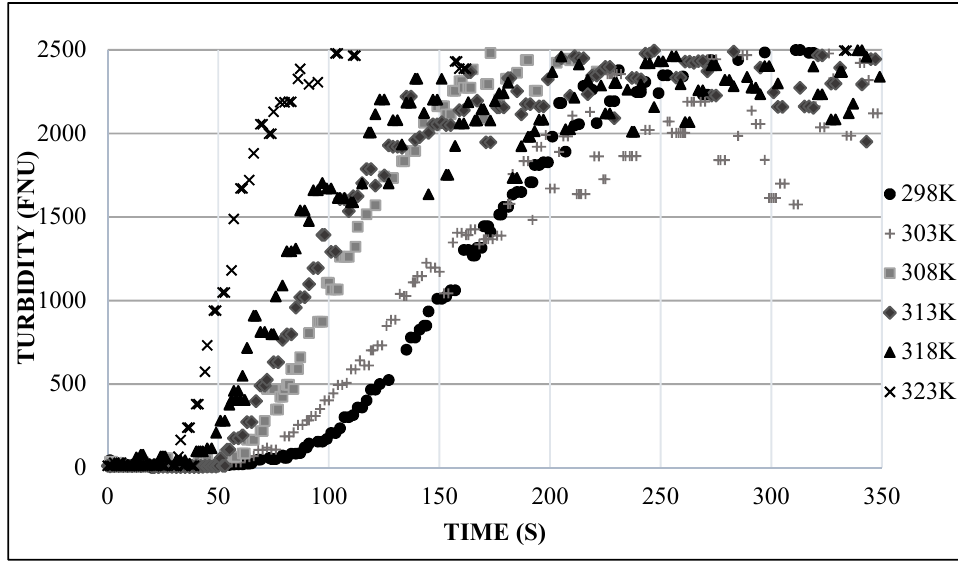
Figure 4. Influence of temperature on induction time: • 298 K; + 303 K; ■ 308 K; ♦ 313 K; ▲ 318 K; × 323 K.